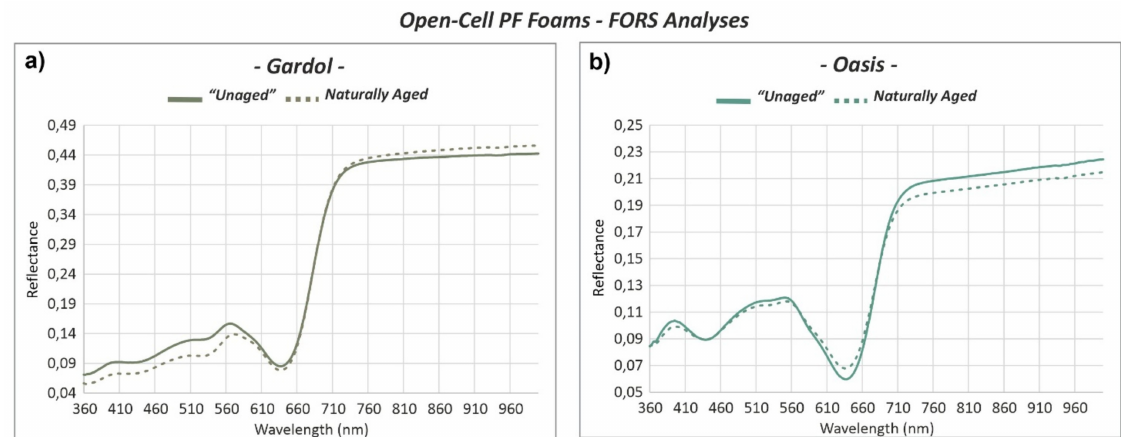
Figure 7. FORS reflectance spectra of the “Unaged” and Naturally Aged ( a ) Gardol and ( b ) Oasis open-cell PF